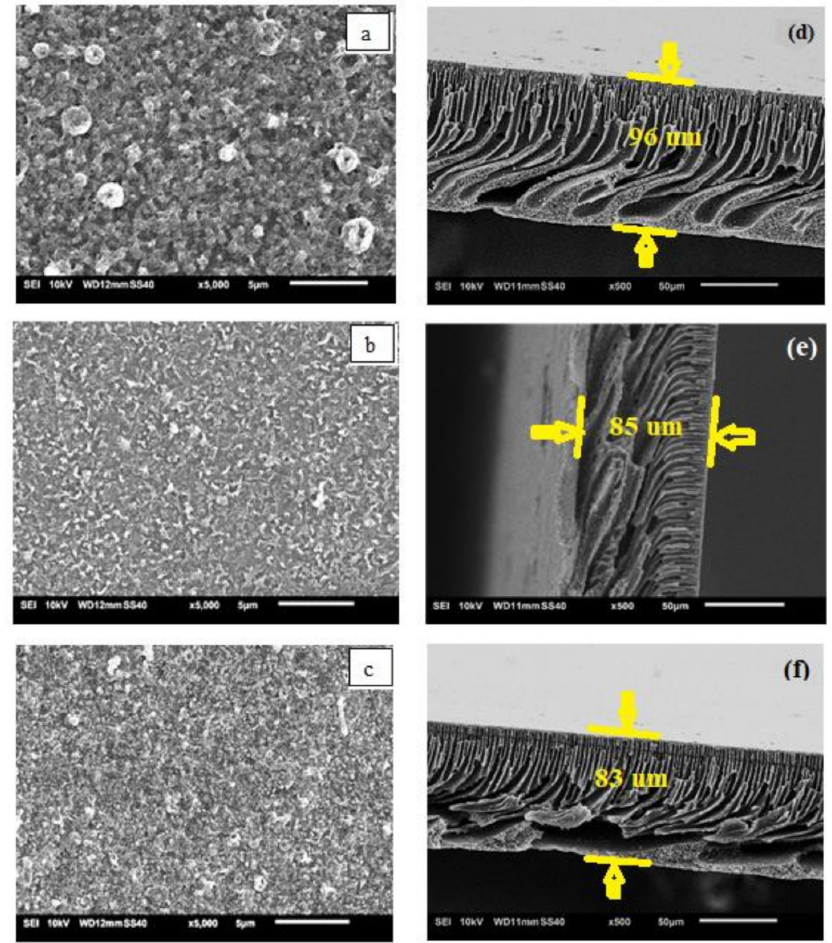
Figure 3. Scanning electronic micrography (SEM) top surfaces ( a – c ) and their respective cross sections ( d – f ) for the three TFC FO